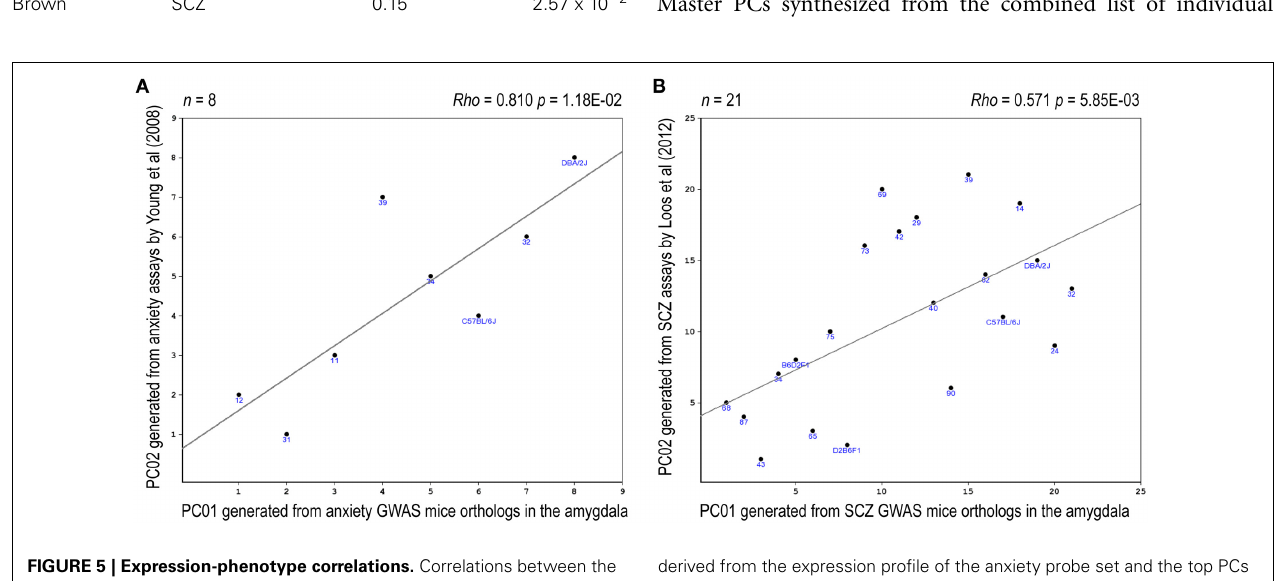
derived from the expression profile of the anxiety probe set and the top PCs derived from anxiety-related behavioral traits. (B) Correlation between the top PCs derived from the expression profile of the SCZ probe set and the top PC derived from prepulse inhibition-related behavioral traits.